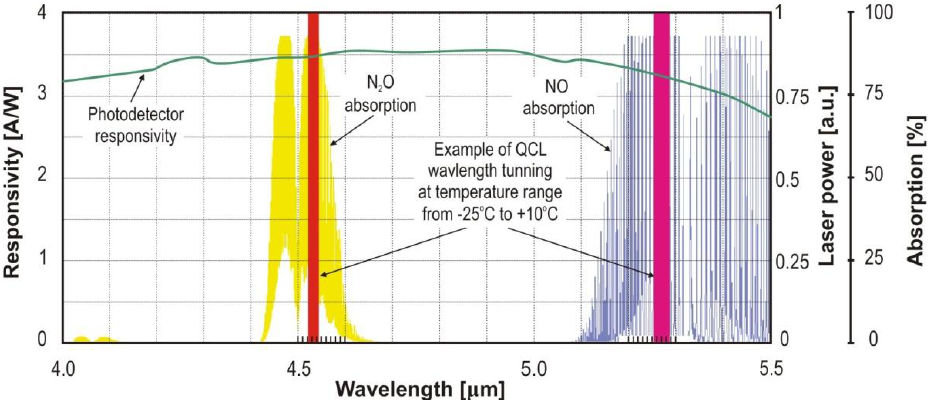
Figure 19. Characteristics of the selected QC laser spectra, N and photodetector responsivity.